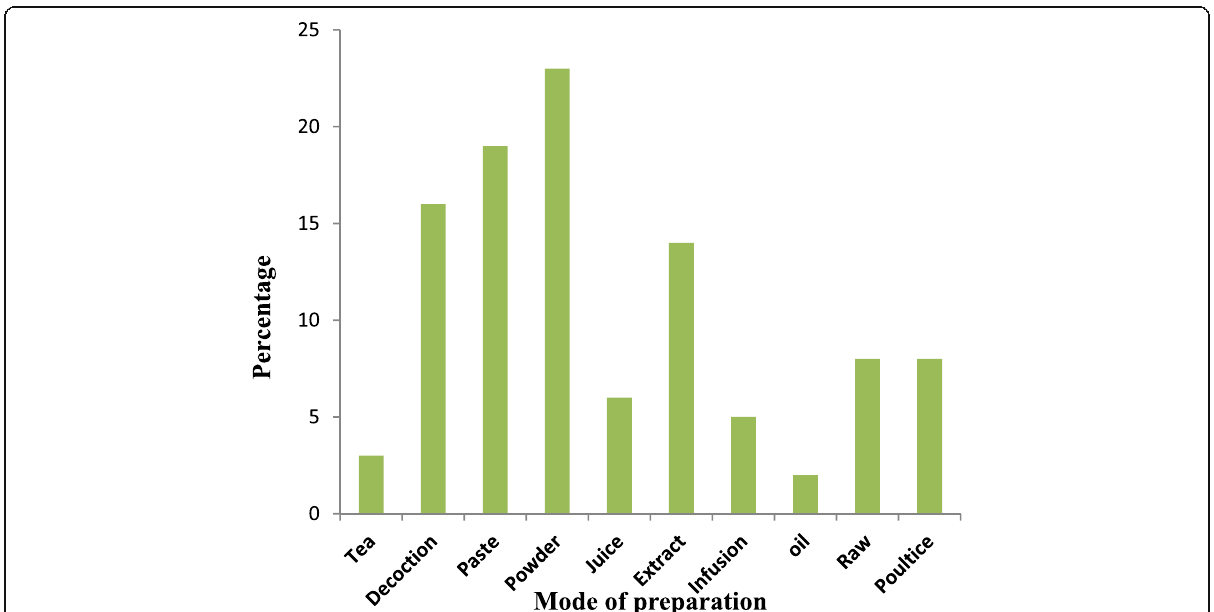
Fig. 4 Mode of utilization of medicinal plants used for skin disorders in Northern Pakistan